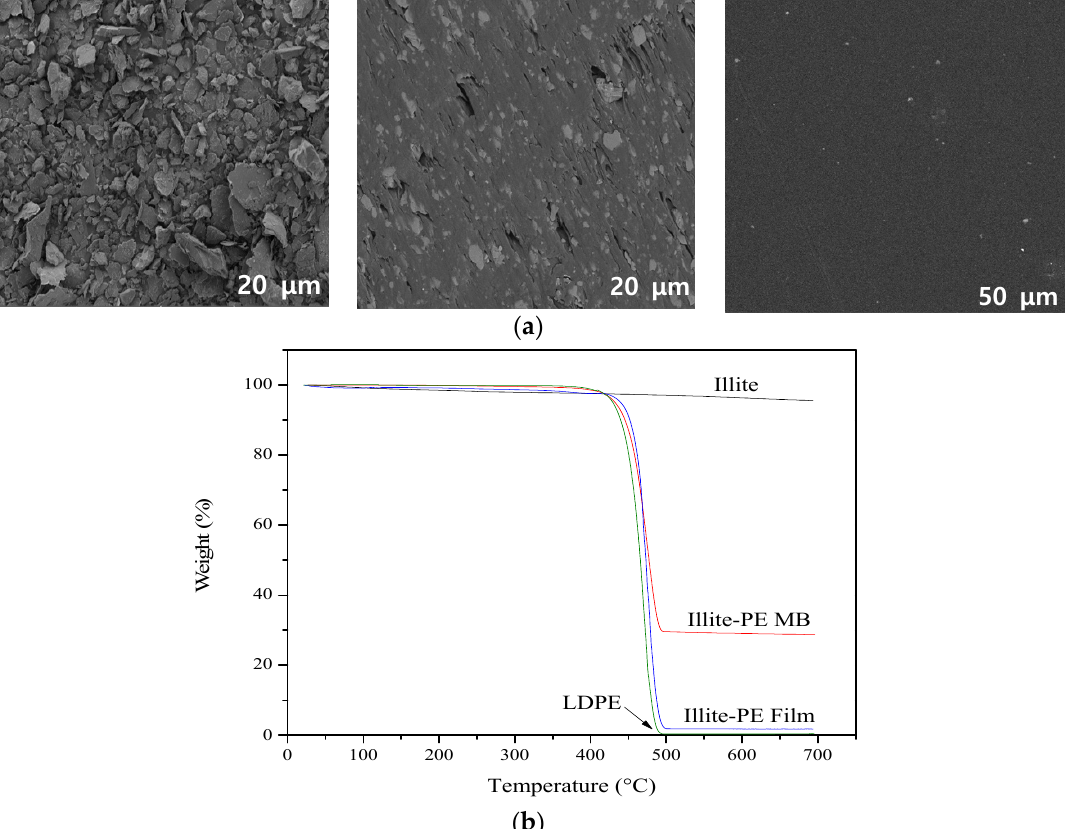
Figure 3. ( a ) SEM images and ( b ) TGA analysis of illite, iliite-PE masterbatch, and iliite-PE film respectively.